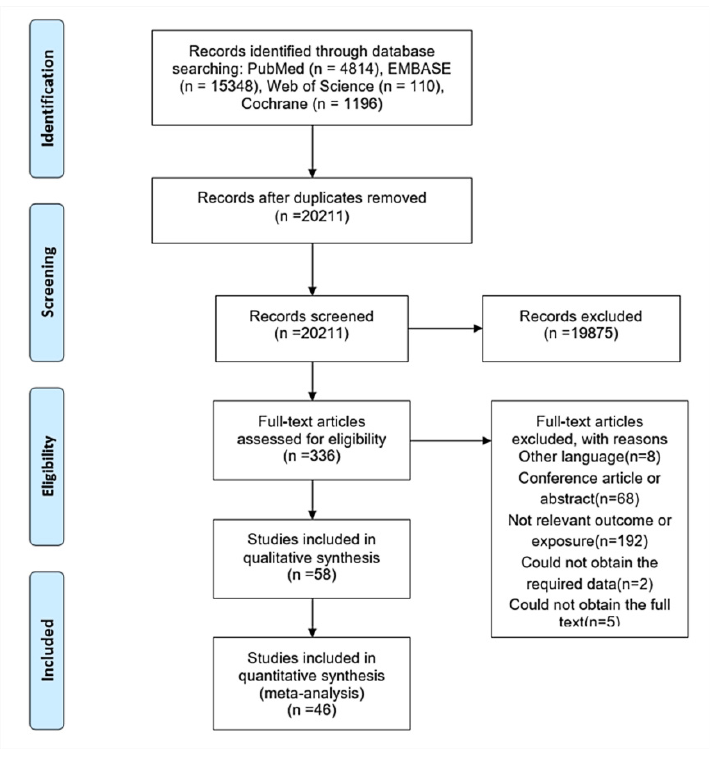
Figure 1. Flowchart of the literature search process. Table 1. Summary characteristics of the unique studies included in this review.